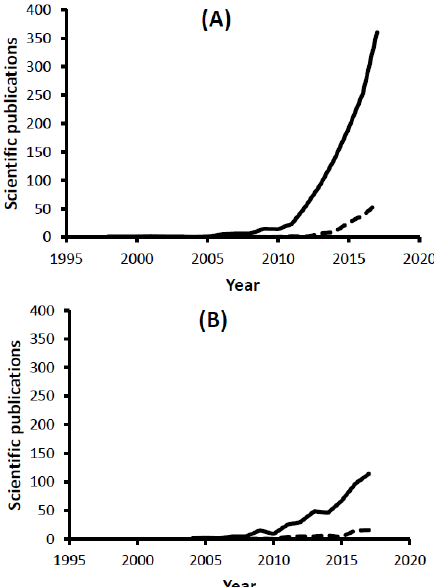
Figure 1. Number of scientific publications available on the literature on antimicrobial resistance (AMR) and whole genome sequencing (WGS) or whole metagenome sequencing (WMS). ( A ) Scientific publications obtained at [22] using the following search terms “whole genome sequencing AND (antimicrobial resistance OR antibiotic resistance)” (continuous line) or “whole genome sequencing AND food AND (antimicrobial resistance OR antibiotic resistance)” (discontinuous line); ( B ) Scientific publications obtained at [22] using the following search terms “metagenomic AND (antimicrobial resistance OR antibiotic resistance)” (continuous line) or “metagenomic AND food AND (antimicrobial resistance OR antibiotic resistance)” (discontinuous